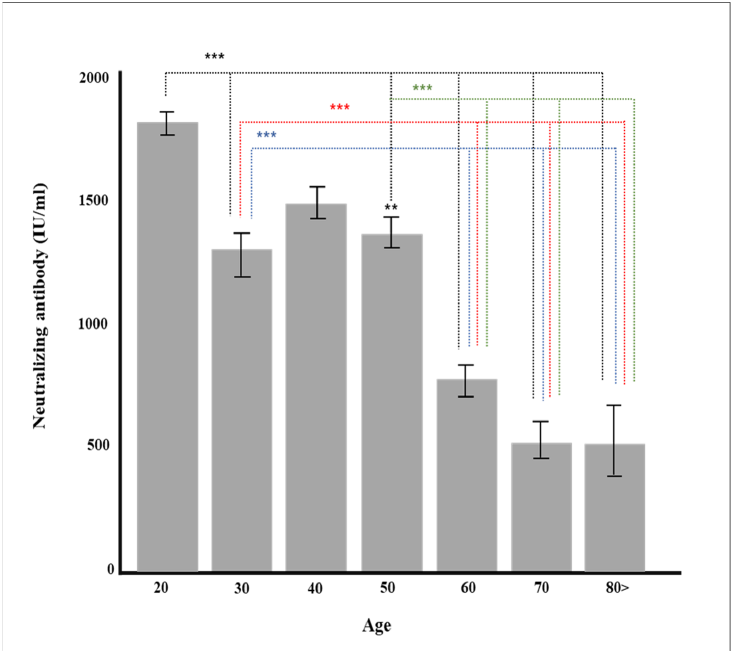
Figure 2. Production of neutralizing antibody according to age (** p < 0.01, *** p < 0.001).